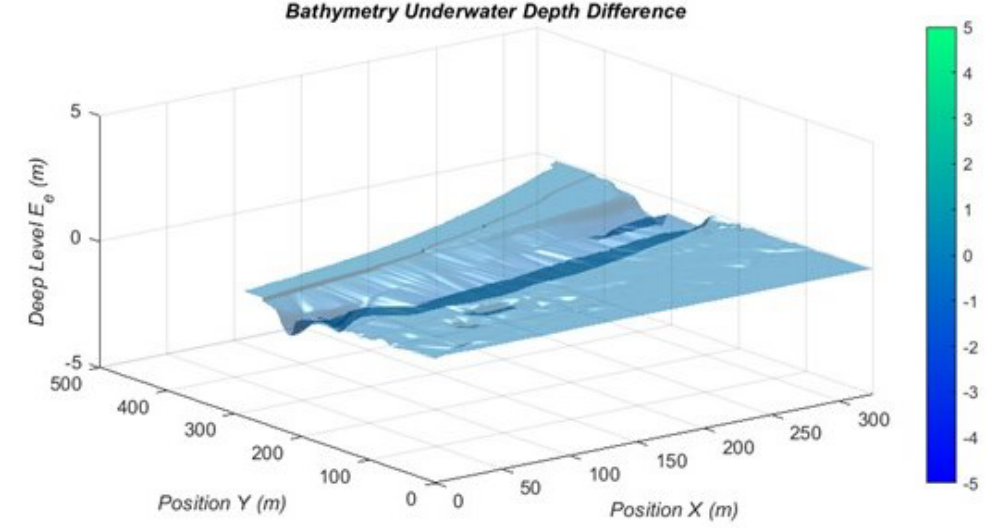
Figure 18. Underwater depth differences between the corrected and measured